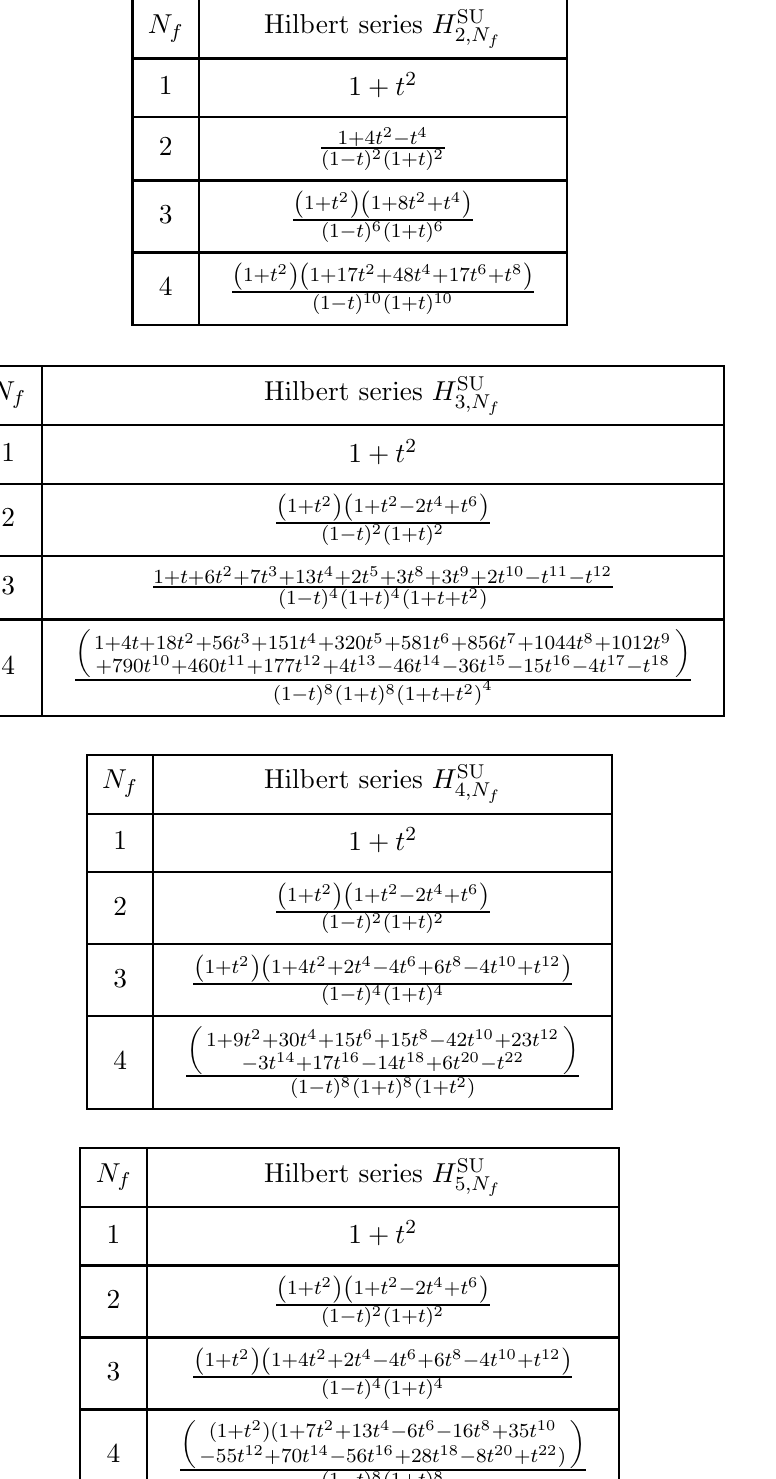
for SU( N c ) SQCD with N f flavors with 2 N c ,N f